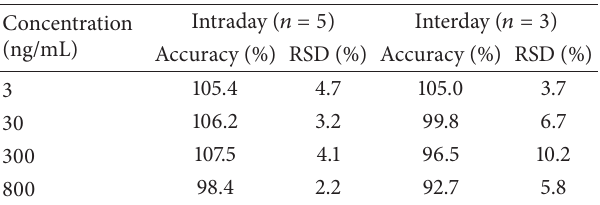
Table 1: Intra- and interday precision and accuracy of epimedin C in rat plasma ( 𝑛 = 5